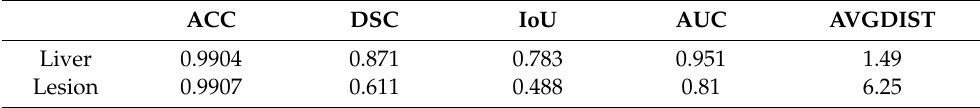
Table 3. Accuracy of liver and lesion identification after training with an additional 30 hospital imaging data